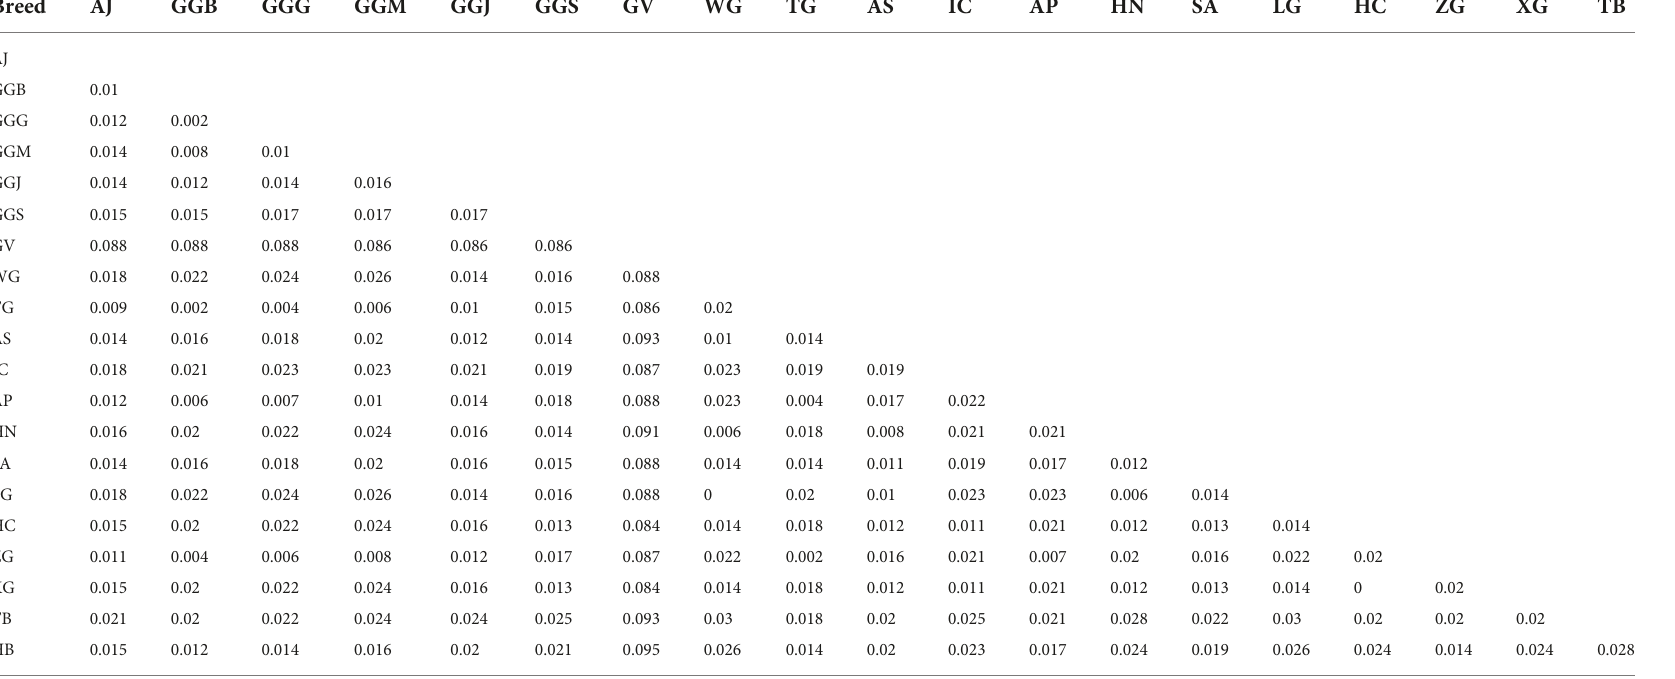
TABLE 4 genetic distance between Anjian chicken and other 19 breeds.